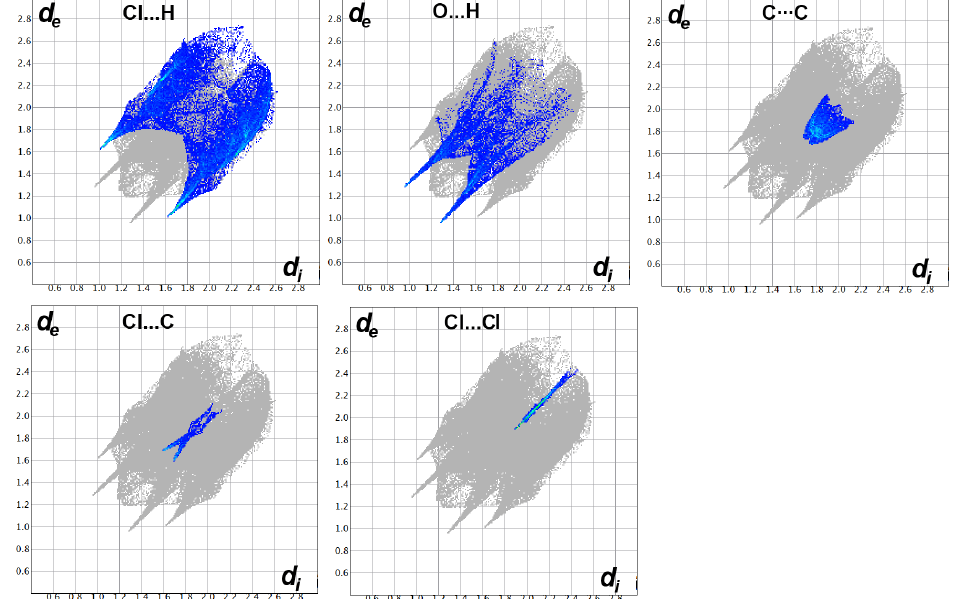
Figure 11. Fingerprint plots of the short contacts in Pd(II) complex 4 .